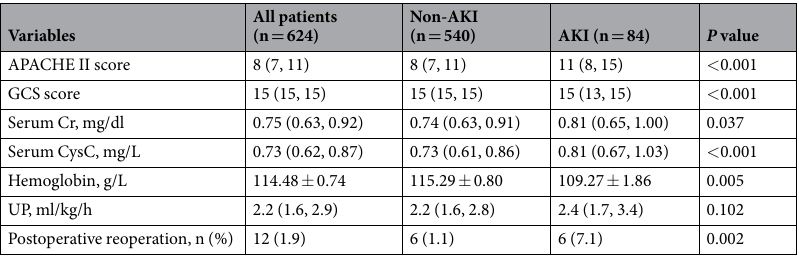
Table 3. Postoperative Variables by Status of AKI a . a Continuous variables were expressed as mean ± SD or median (25th percentile–75th percentile, IQR). Categorical variables were expressed as a number (%). Abbreviations: AKI, acute kidney injury; APACHE II, Acute Physiology and Chronic Health Evaluation; GCS, Glasgow Coma Score; Cr, creatinine, CysC, Cystatin C; UP, urine production within the first 24 hours after operation; Postoperative reoperation, underwent the second neurosurgical operation within 7 days after first neurosurgical procedure.